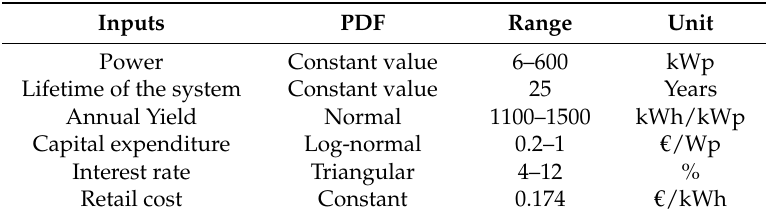
Table 2. PDFs used in the Monte Carlo calculation.